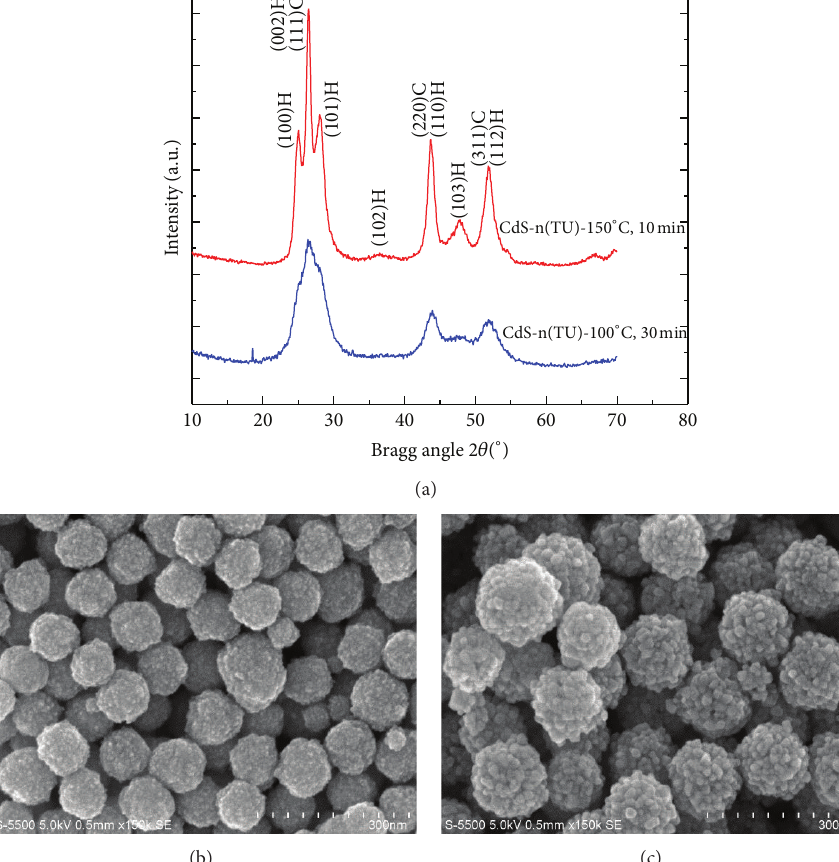
Figure 2: (a) XRD patterns and SEM micrographs of CdS-n(TU) products synthesized at (b) 100 ∘ C for 30 min and (c) 150 ∘ C for 10min.